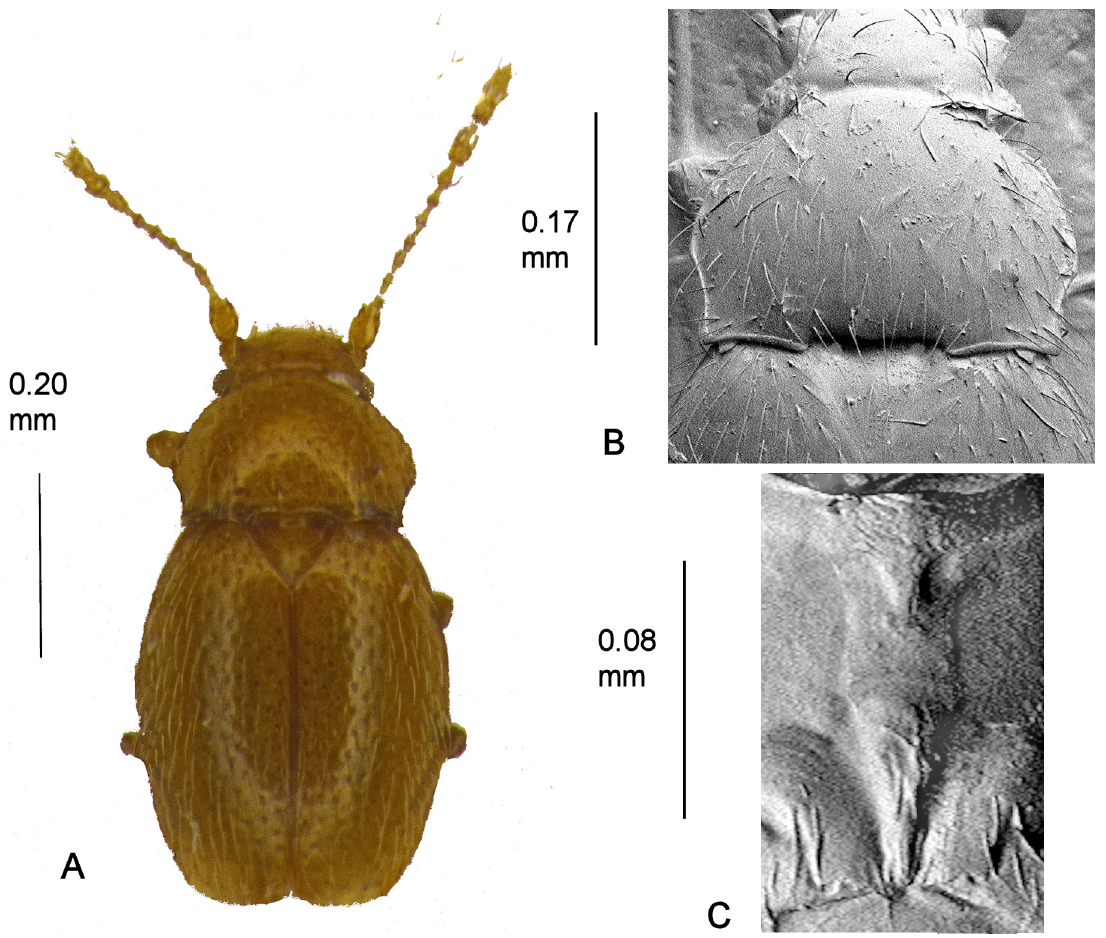
Fig. 71. Cissidium flavum sp. nov. A . Habitus. B . Pronotum, × 585. C . Mesoventrite showing median process of collar, mid-keel and keel,